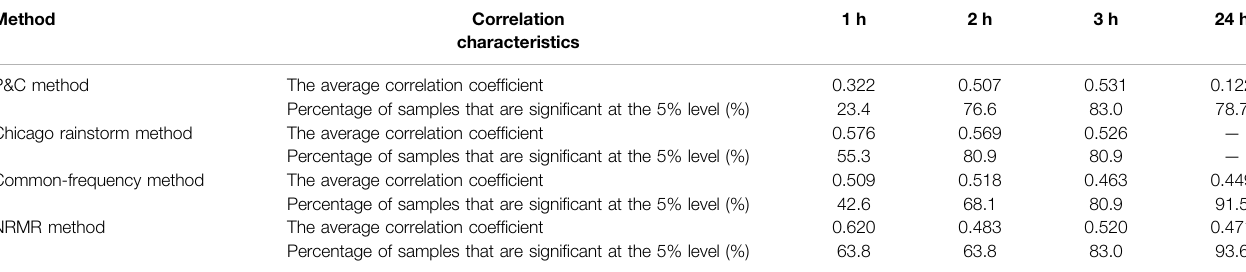
TABLE 3 | Correlations between the results of the different rainstorm hyetograph designs and the test samples.